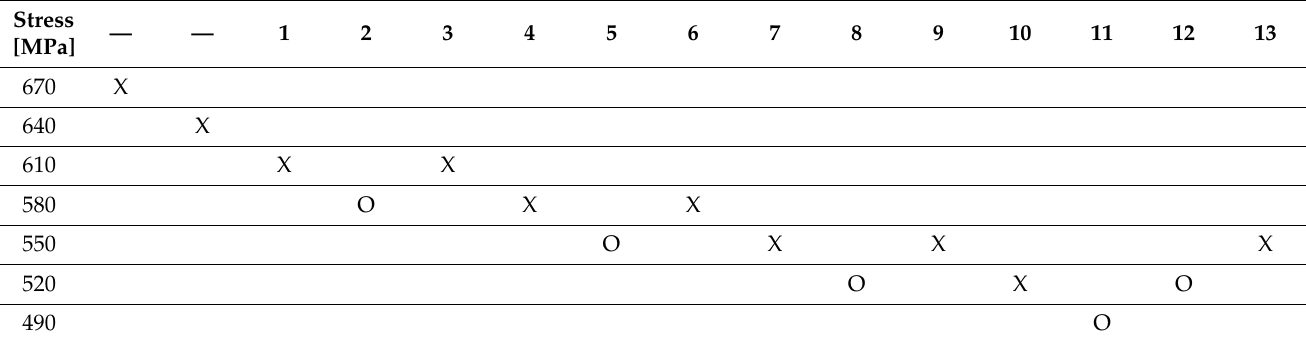
Figure 9. Crack initiation site in a sample of Set HMP-M.